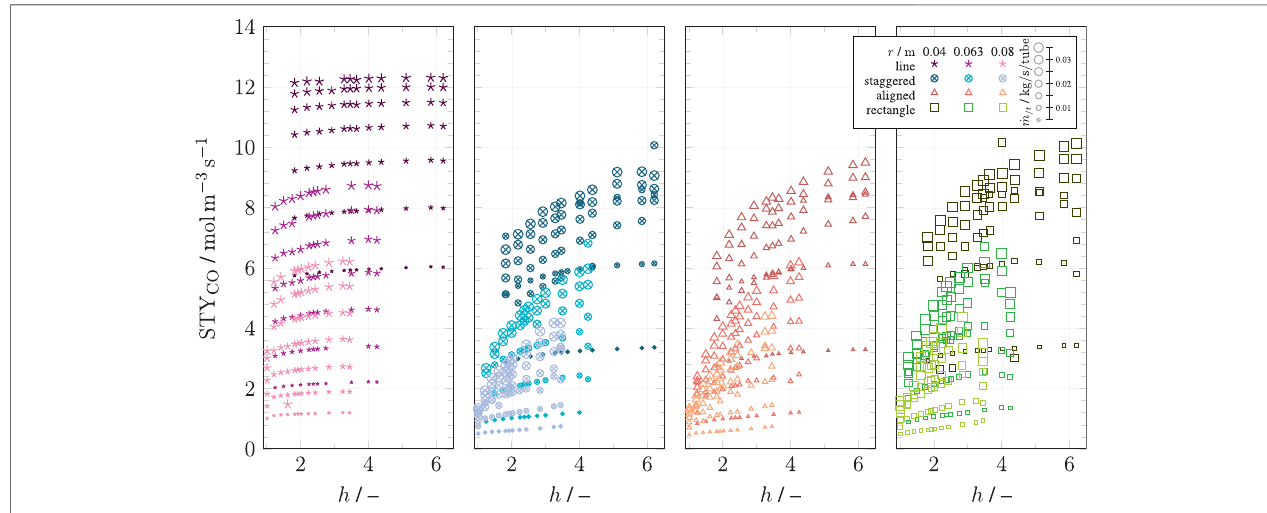
FIGURE 13 | The space-time yield STY i CO as a function of the distance factor h — shown for each con fi guration individually. The symbol (and its color family) indicates the con fi guration of the data point. Shades of the respective color indicate the inner tube radius r . Symbol size indicates the mass fl ow rate _ m / t of fl ue gas per reforming tube.